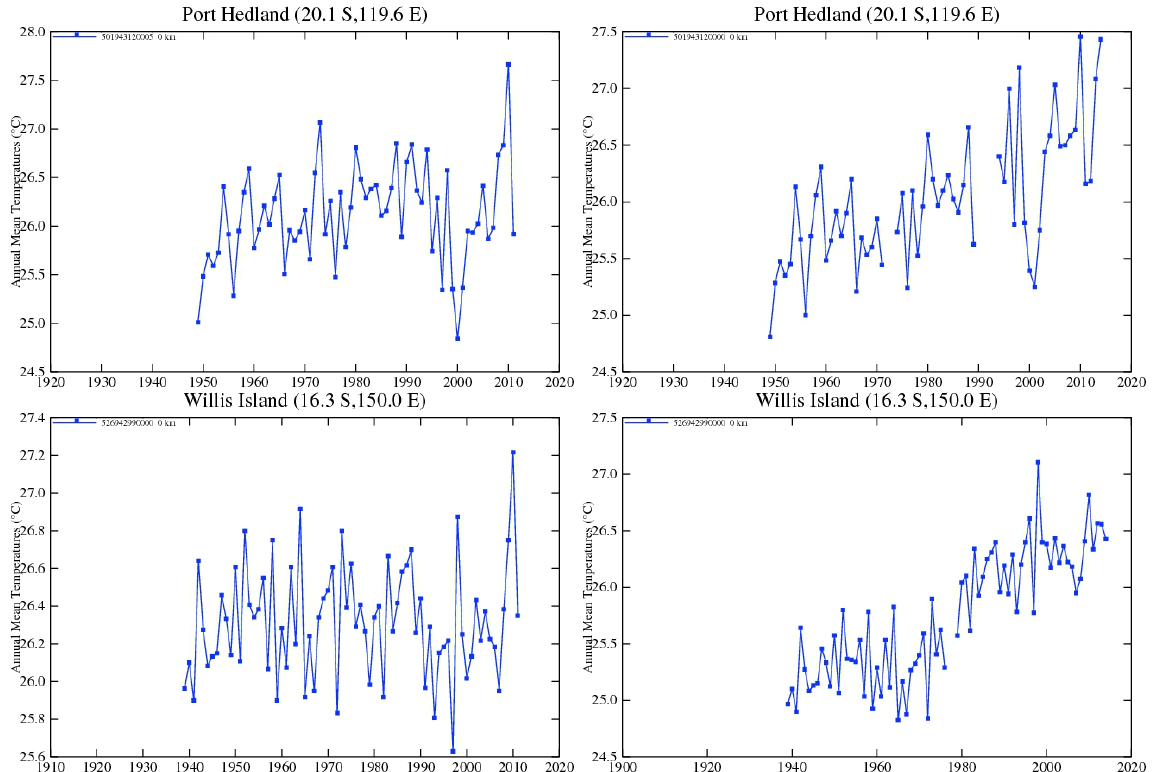
Fig. A.2: (Continued) GISS v2 vs. v3 temperature records for Darwin and Alice Springs, Northern Territory, Wilson Promontory, Cape Otway and Ballarat, Victoria, Adelaide Airport, South Australia, Eucla, Western Australia, Yamba, New South Wales, Brisbane/Eagle Farm, Queens- land, Carnarvon, Western Australia, Port Headland, Western Australia and Willis Island, an external territory of Australia. GISS v2 data on the left, GISS v3 data on the